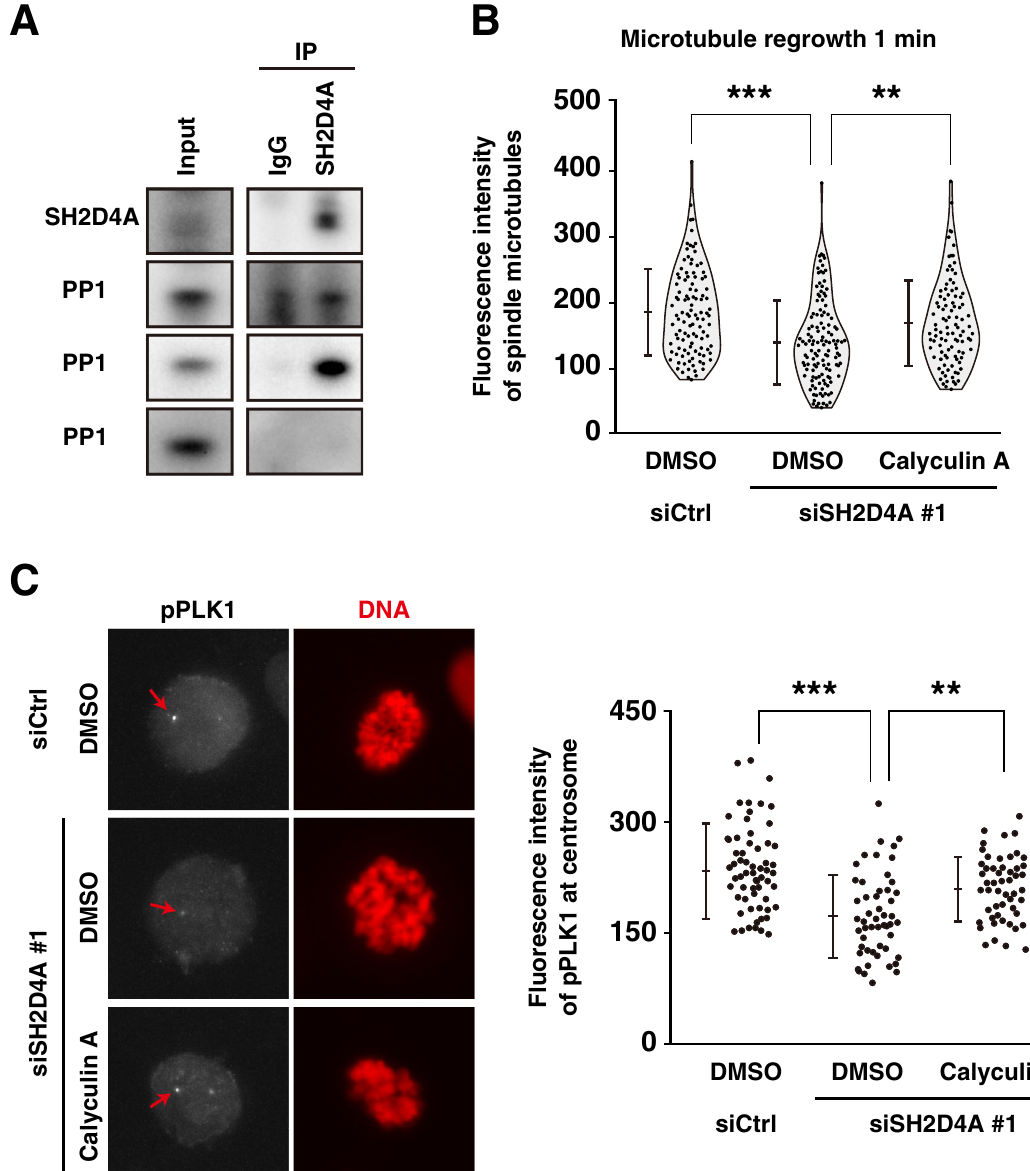
Figure 5. SH2D4A-mediated regulation of active PLK1 accumulation at centrosomes and microtubule nucleation through binding to PP1. ( A ) A549 cells were treated with 5 µM STLC for 16 h to arrest at mitosis. SH2D4A immunoprecipitates were subjected to Western blot analysis using indicated antibodies. ( B , C ) A549 cells were transfected with siCtrl or siSH2D4A #1. ( B ) At 28 h after siRNA transfection, cells were treated with 6 µM RO-3306 for 20 h, washed, cultured in fresh media for 10 min, and incubated on ice for 4 h with or without 2 nM calyculin A during the last 30 min. After incubation at 37 °C for 1 min with or without calyculin A, the cells were fixed and stained for α-tubulin and DNA. The fluorescence intensity of α-tubulin was measured and plotted as the mean ± SD from a representative experiment of two independent experiments (n > 100). Violin plots with data points are also shown. ( C ) At 28 h after siRNA transfection, cells were treated with 6 µM RO-3306 for 20 h with or without 2 nM calyculin A during the last 30 min. RO-3306-treated cells were washed, cultured in fresh media for 30 min with or without calyculin A. Then, the cells were fixed and stained for phospho-PLK1 (gray) and DNA (red). (Left) Representative images of prometaphase cells are shown. The focus was set to one of the centrosomes, and the red arrows indicate the centrosome. Scale bar, 10 µm. (Right) The fluorescence intensity of phospho-PLK1 at centrosomes in prometaphase per cell was measured and the average between the two centrosomes was plotted as the mean ± SD from a representative experiment of two independent experiments (n > 52). Asterisks indicate significant differences (Tukey’s test, ** p < 0.01; *** p < 0.001). Full blots are shown in Fig.